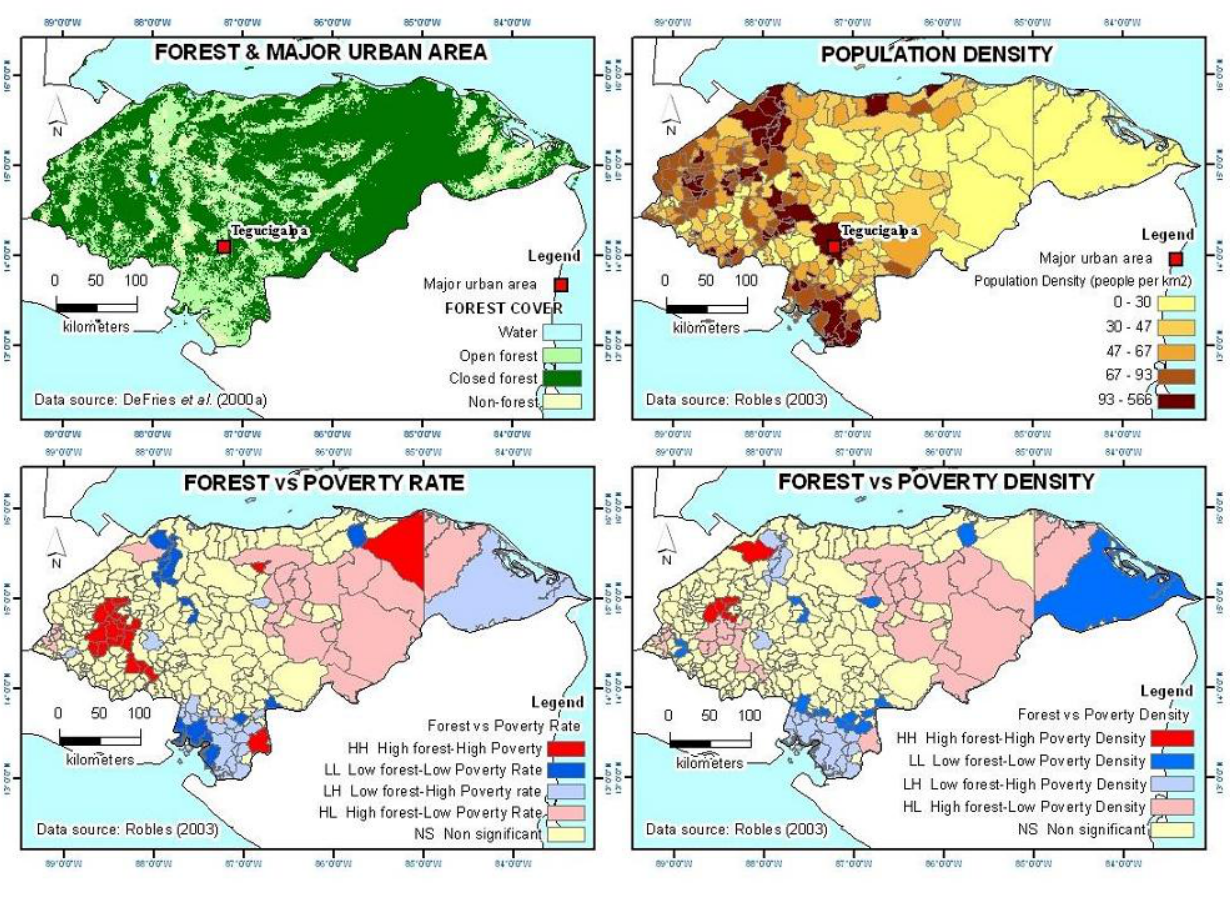
Fig. 2. Honduras. Maps of forest and major urban areas, population density, local indicators of spatial association (LISA) analysis of forest cover by poverty rate, and LISA analysis of forest cover by poverty